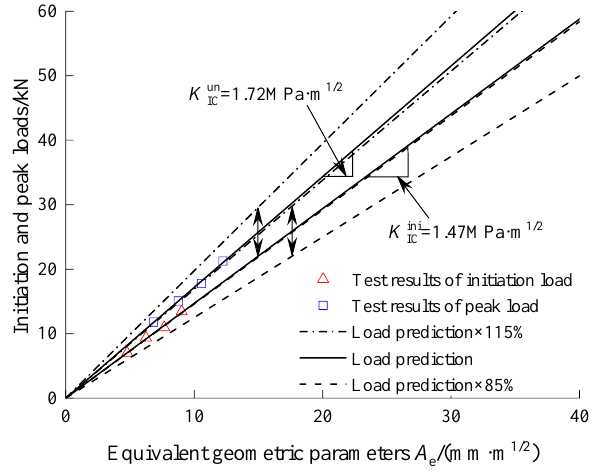
Figure 14. Predicted results of initiation and peak loads.